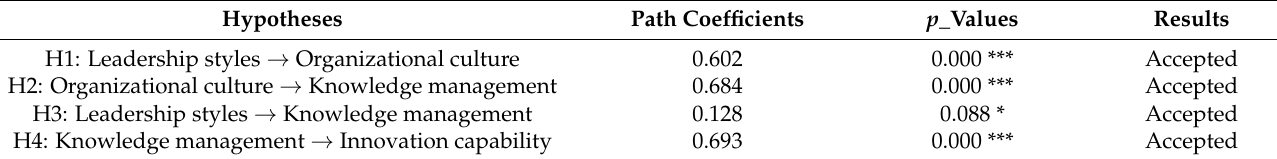
Table 7. PLS-SEM path